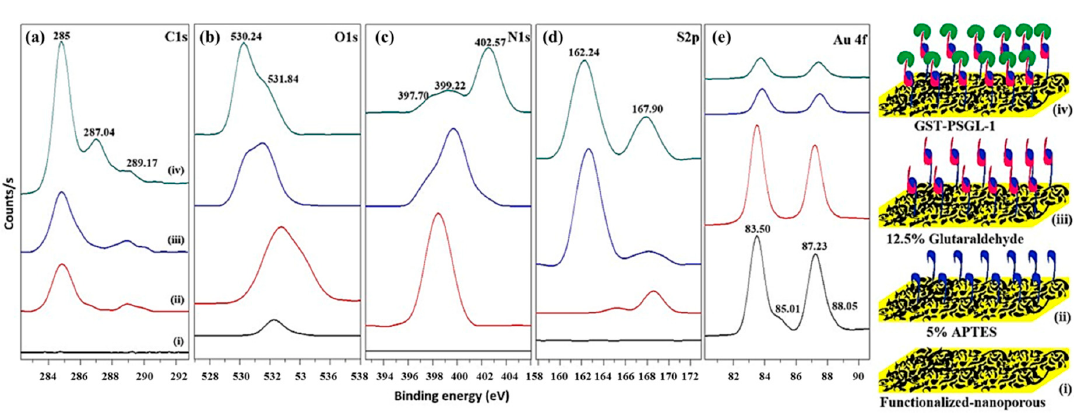
Figure 4. The XPS spectra of protein immobilization on the Au nanoporous substrate were characterized. ( a ) C 1 s , ( b ) O 1 s , ( c ) N 1 s , ( d ) S 2 p and ( e ) Au 4 f spectra were respectively present for verifying chemical components on the Au nanoporous substrate.